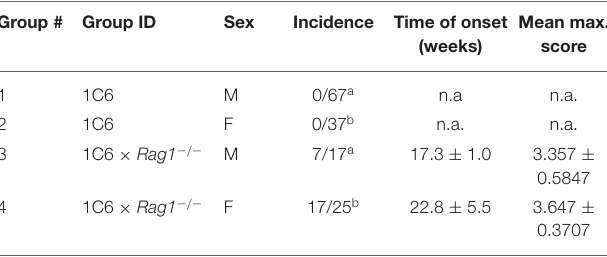
TABLE 1 | Incidence and severity of 1C6 × Rag1 − / − spontaneous